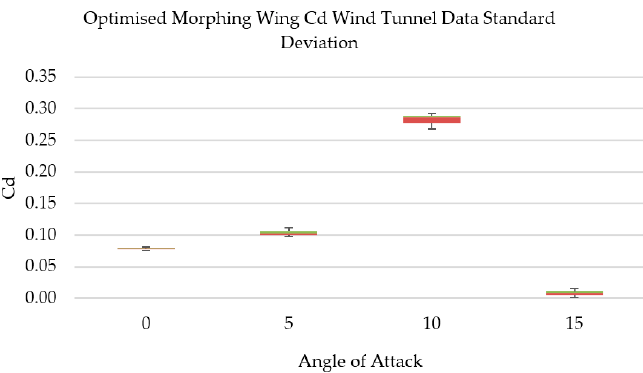
Figure 5. Optimized wing lift coefficient wind tunnel data standard deviation.